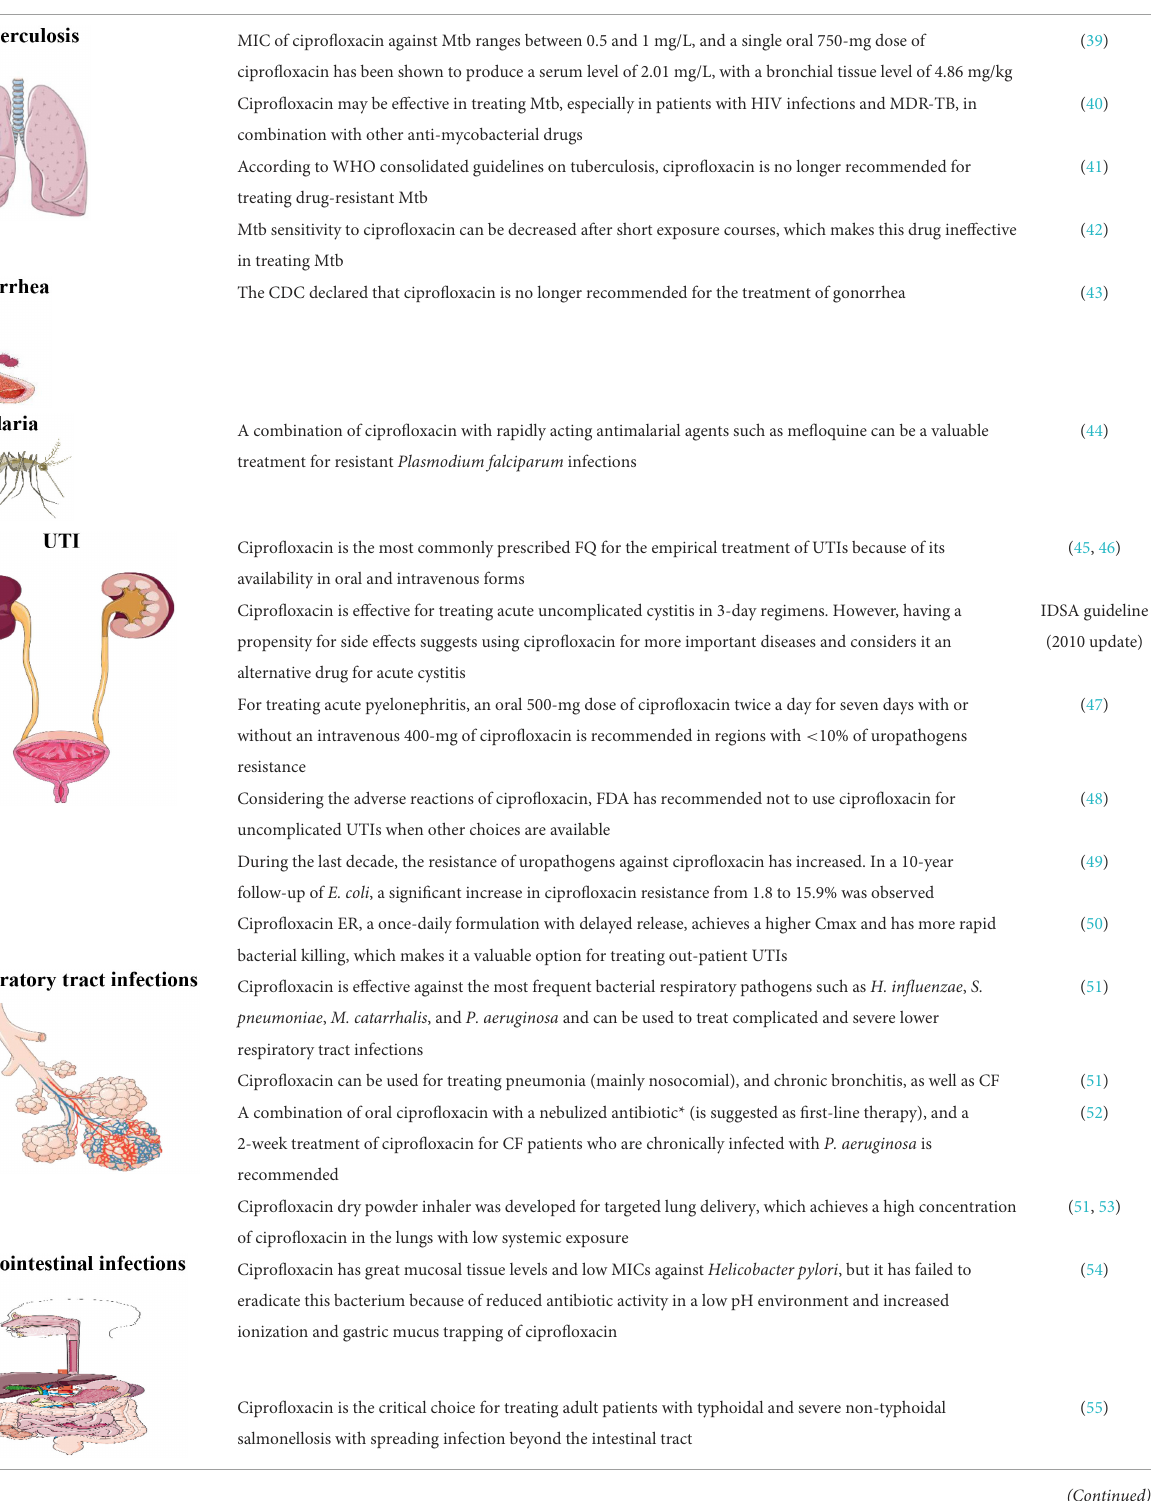
TABLE 2 Schematic view of clinical usage of